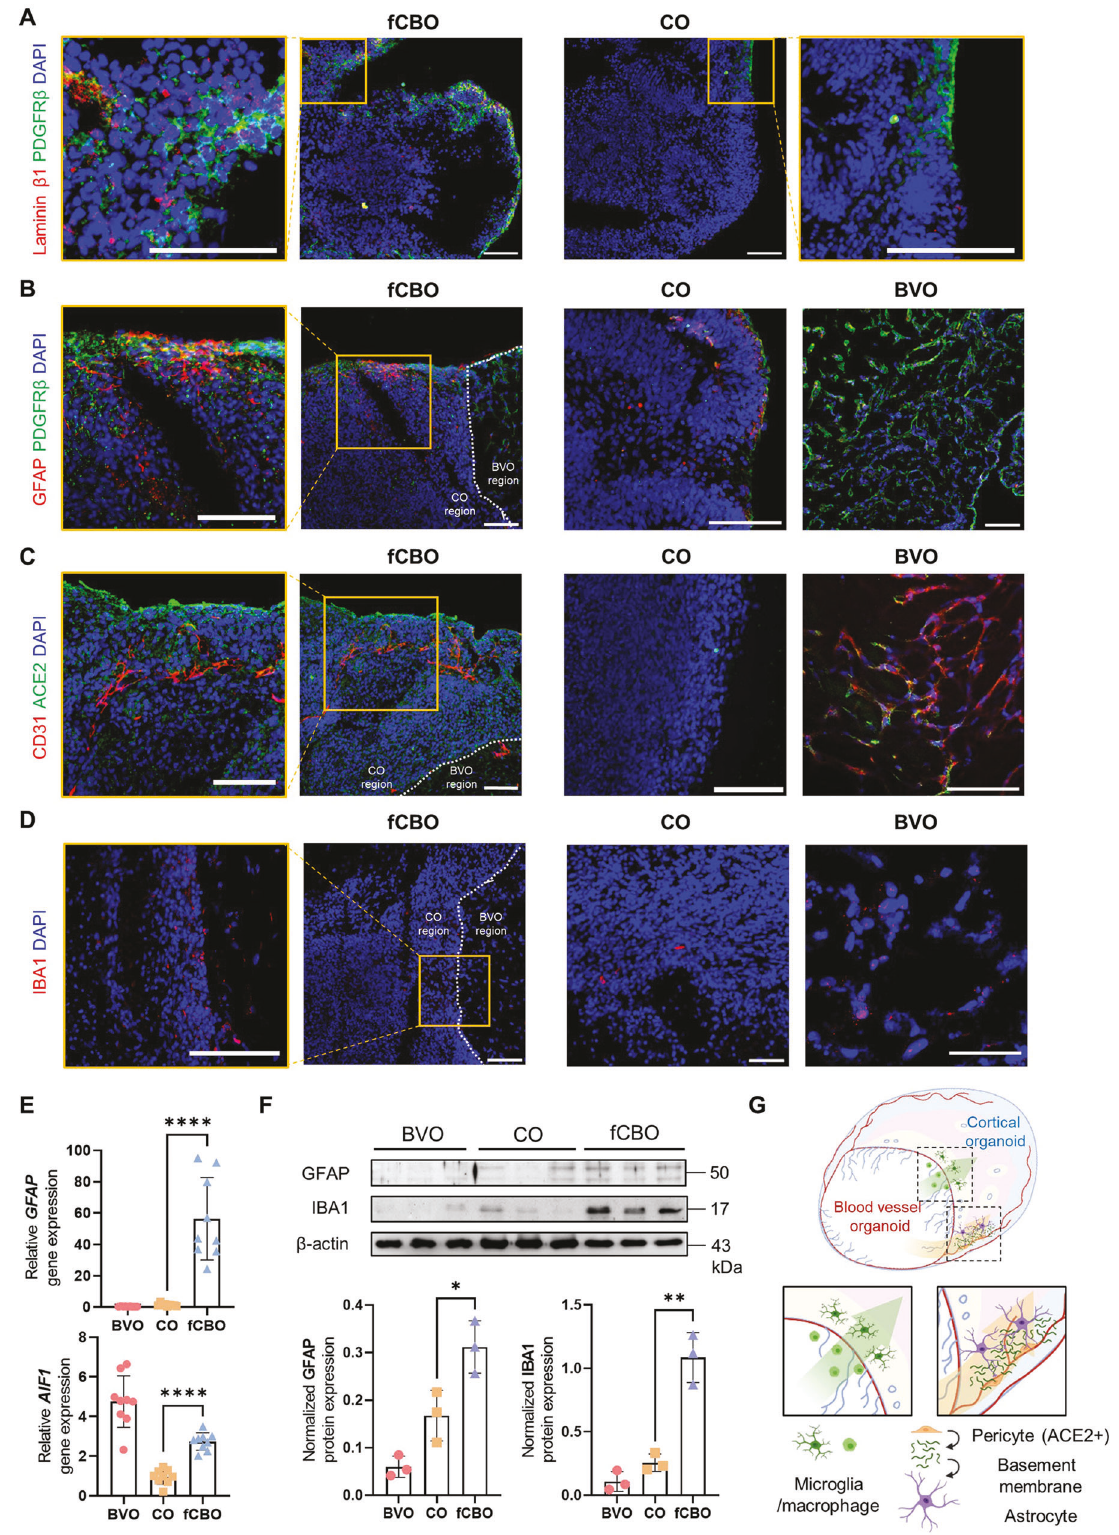
SARS-CoV-2 infected fused cortical-blood vessel organoids exhibit Alzheimer ’ s disease pathology Aberrant Tau localization with phospho-Tau (pTau) expression in SARS-CoV-2 infected neurons of brain organoids was observed in Cell Death Discovery (2023)